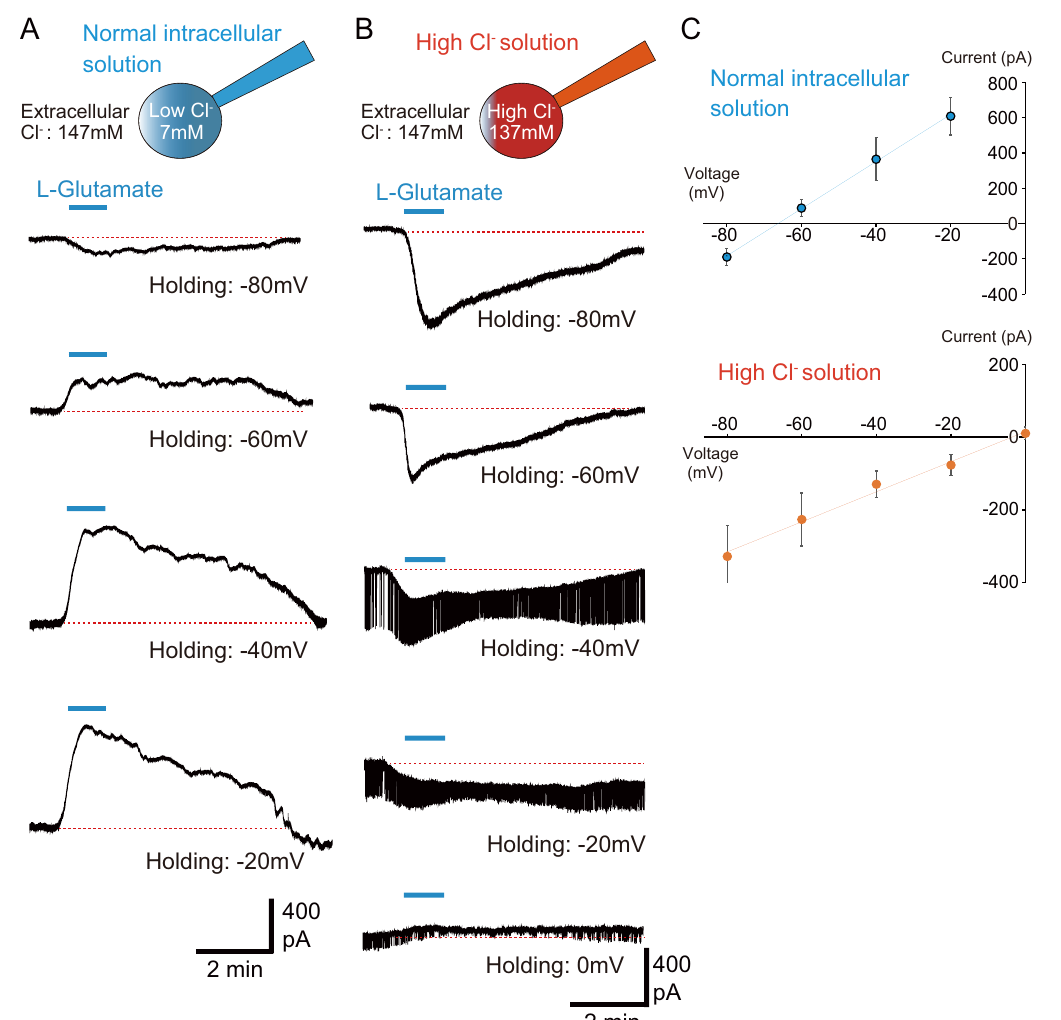
Fig 5. L-Glutamate induced currents in PI neurons are mediated by chloride ion. (A, B) Representative traces showing 1 mM of L-Glutamate-induced currents at each holding potential using (A) normal intracellular solution and (B) high intracellular Cl − solution. (C) Graphs showing the current–voltage curves of glutamate-induced currents in the normal intracellular solution (upper, n = 5) and high Cl − solution (lower, n = 5). Plots with error bars indicate mean value ± SEM. The underlying data can be found in the S1 Data datasheet of numerical values for each fig.xlsx. PI, pars intercerebralis.